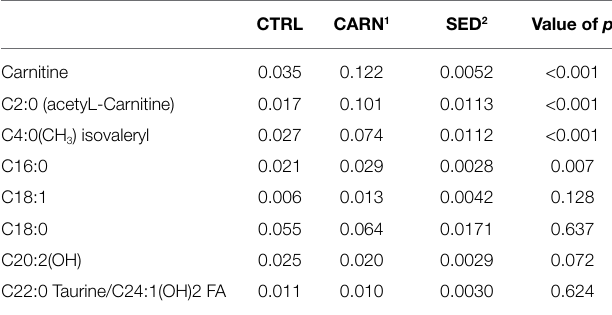
TABLE 3 | Plasma carnitine and acyL-Carnitine concentrations ( μ g/ml) of early feed restricted lambs being fed the control (CTRL) or the L-Carnitine diet (CARN) during the fattening